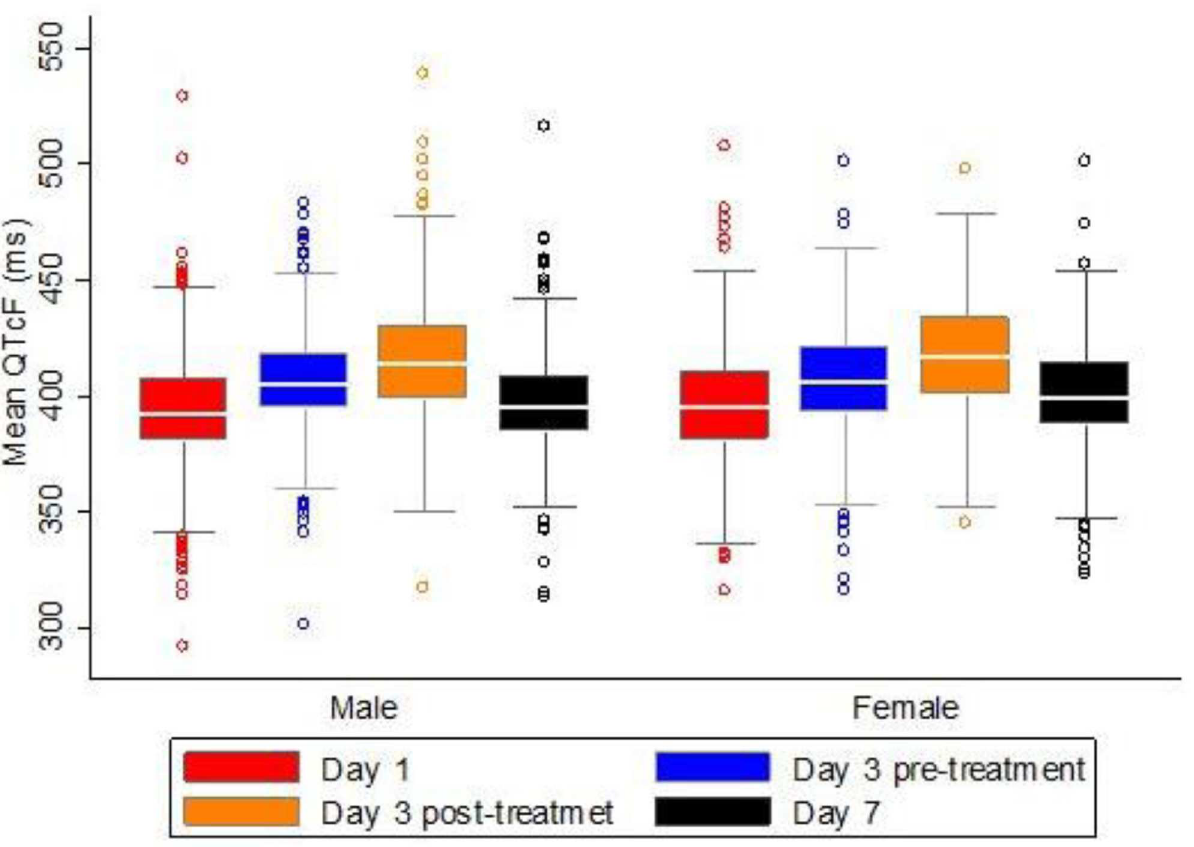
Fig 2. Mean QTcF over time by